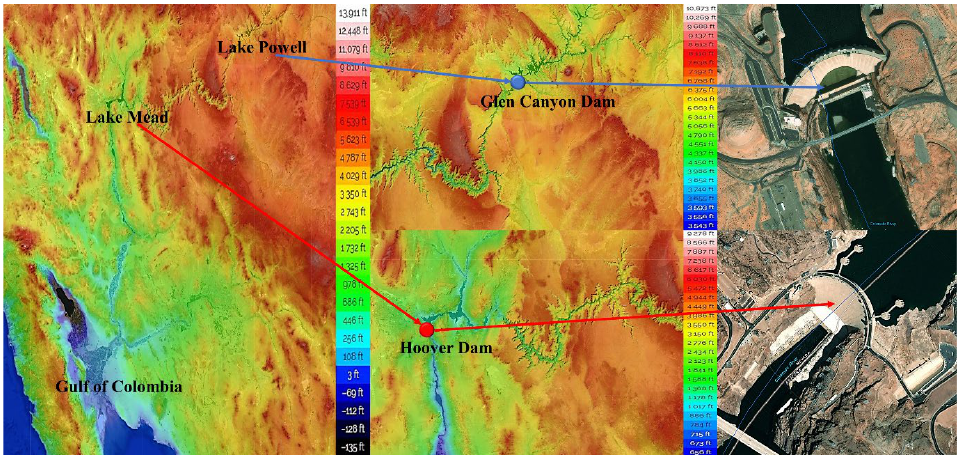
Figure 9. Contour topographic map of two dams and their surroundings. Source: topographic-map https://en-us.topographic-map.com (accessed on 20 January 2022).